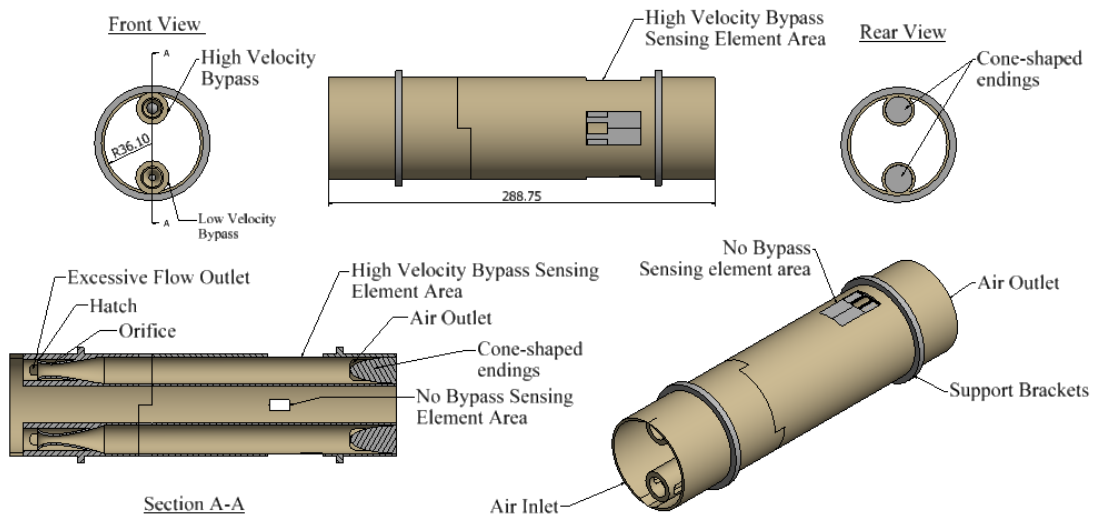
Figure 7. Design geometry schematic (dimensions in mm).